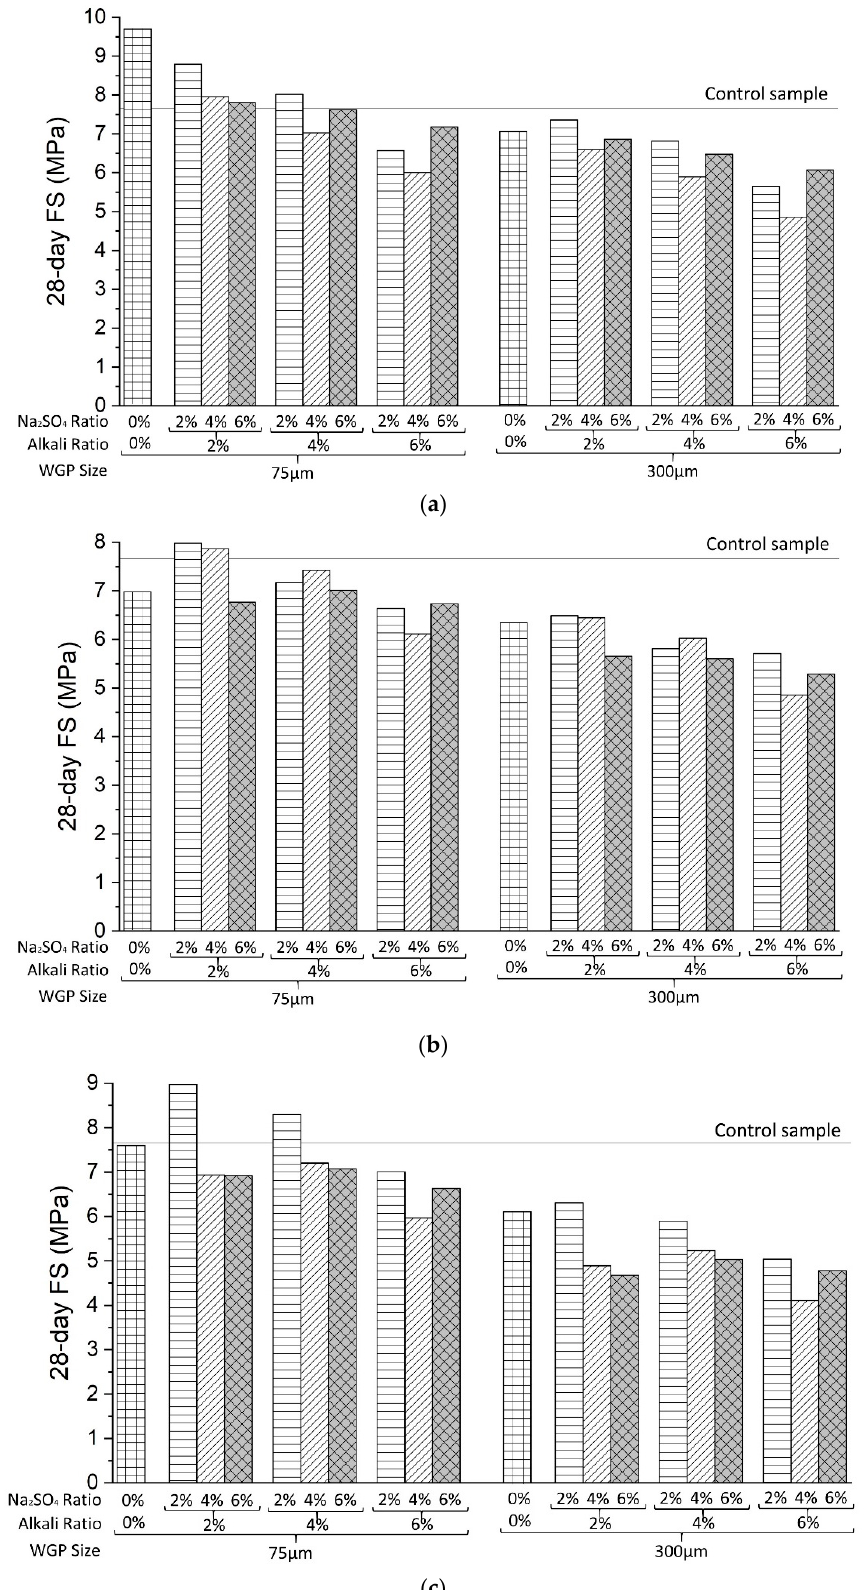
Figure 7. The 28-day FS of mortar containing ( a ) 10%, ( b ) 20%, and ( c ) 30% WGP by chemical activation.